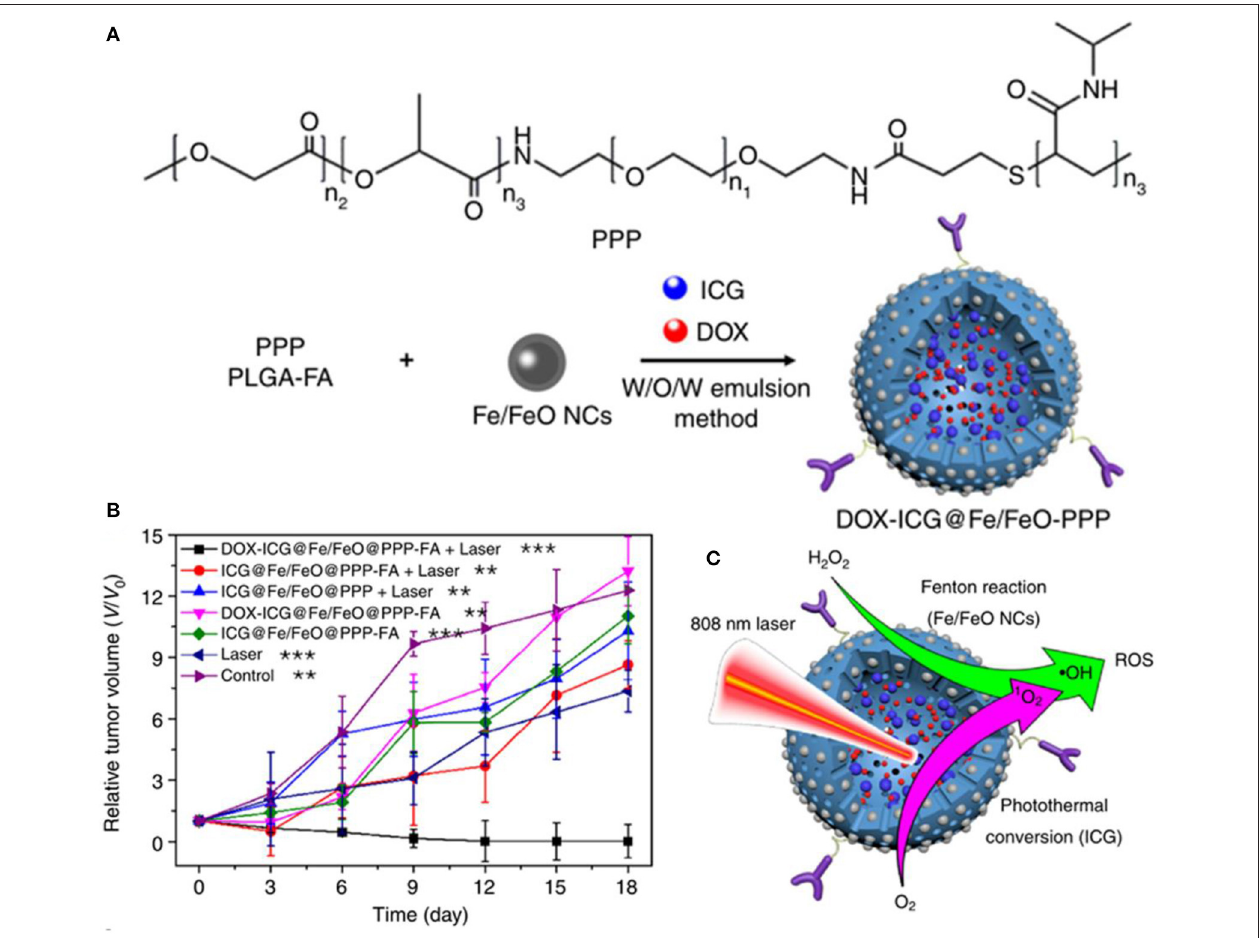
Nature Publishing